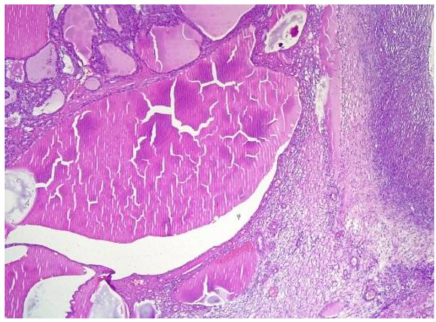
Figure 7. Struma ovarii—multicystic, macrofolicular pattern. HE, 10 ×